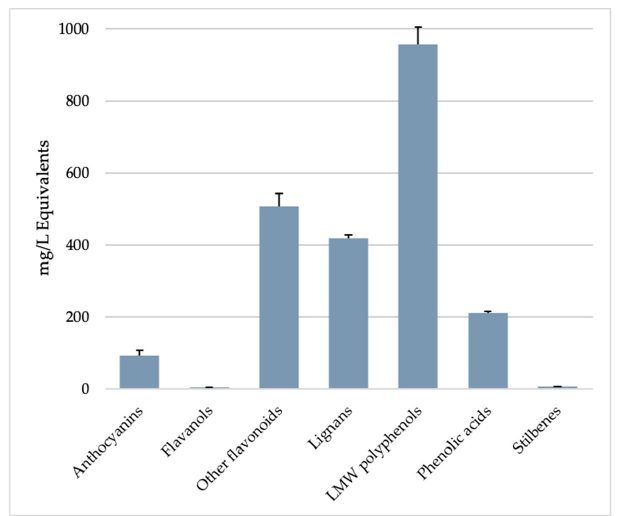
Figure 3. Phenolics composition (as mg/L Equivalents) in Gynostemma pentaphyllum (var. Ginpent) extracts. Abbreviation: LMW: Low molecular weight. Semi-quantitative data per class were obtained from cumulate abundances, using pure standards. In more detail, cyanidin (anthocyanins), catechin (flavanols), luteolin (flavones and remaining flavonoids), sesamin (lignans), ferulic acid (hydroxycinnamic acids and other phenolic acids), resveratrol (stilbenes), and tyrosol (low molecular weight phenolics) were used.